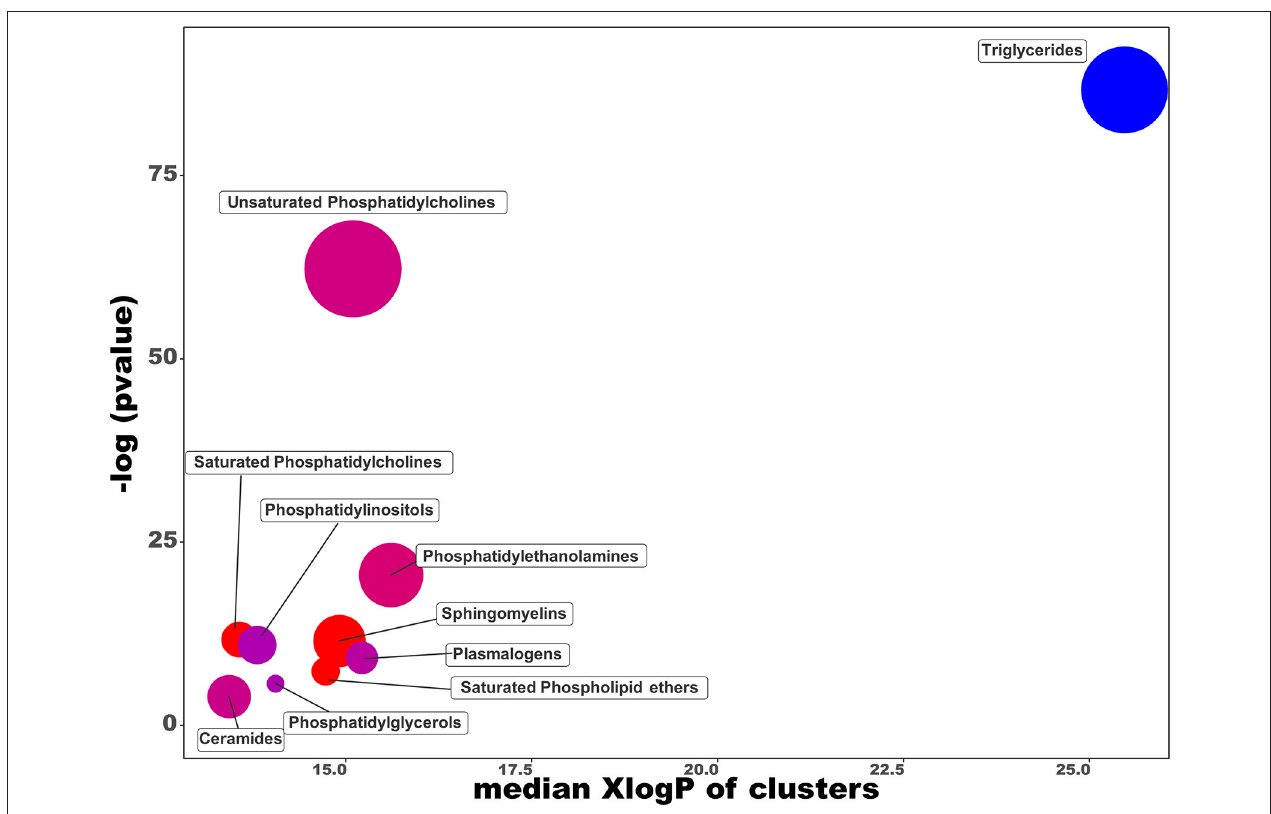
FIGURE 3 | Chemical similarity enrichment analysis of lipidomics data from SH-SY5Y cells treated with olives leaves-sea sand adsorbate (OL-SS) at 40 µ g/mL compared to control conditions for 24h. The x -axis shows X log P -values of lipid clusters, y -axis shows the most significantly altered clusters on top. Clusters in red indicate an overall proportion of increased compounds, and blue clusters indicate an overall proportion of decreased compounds. Only enrichment clusters that are significantly different at p < 0.05 are